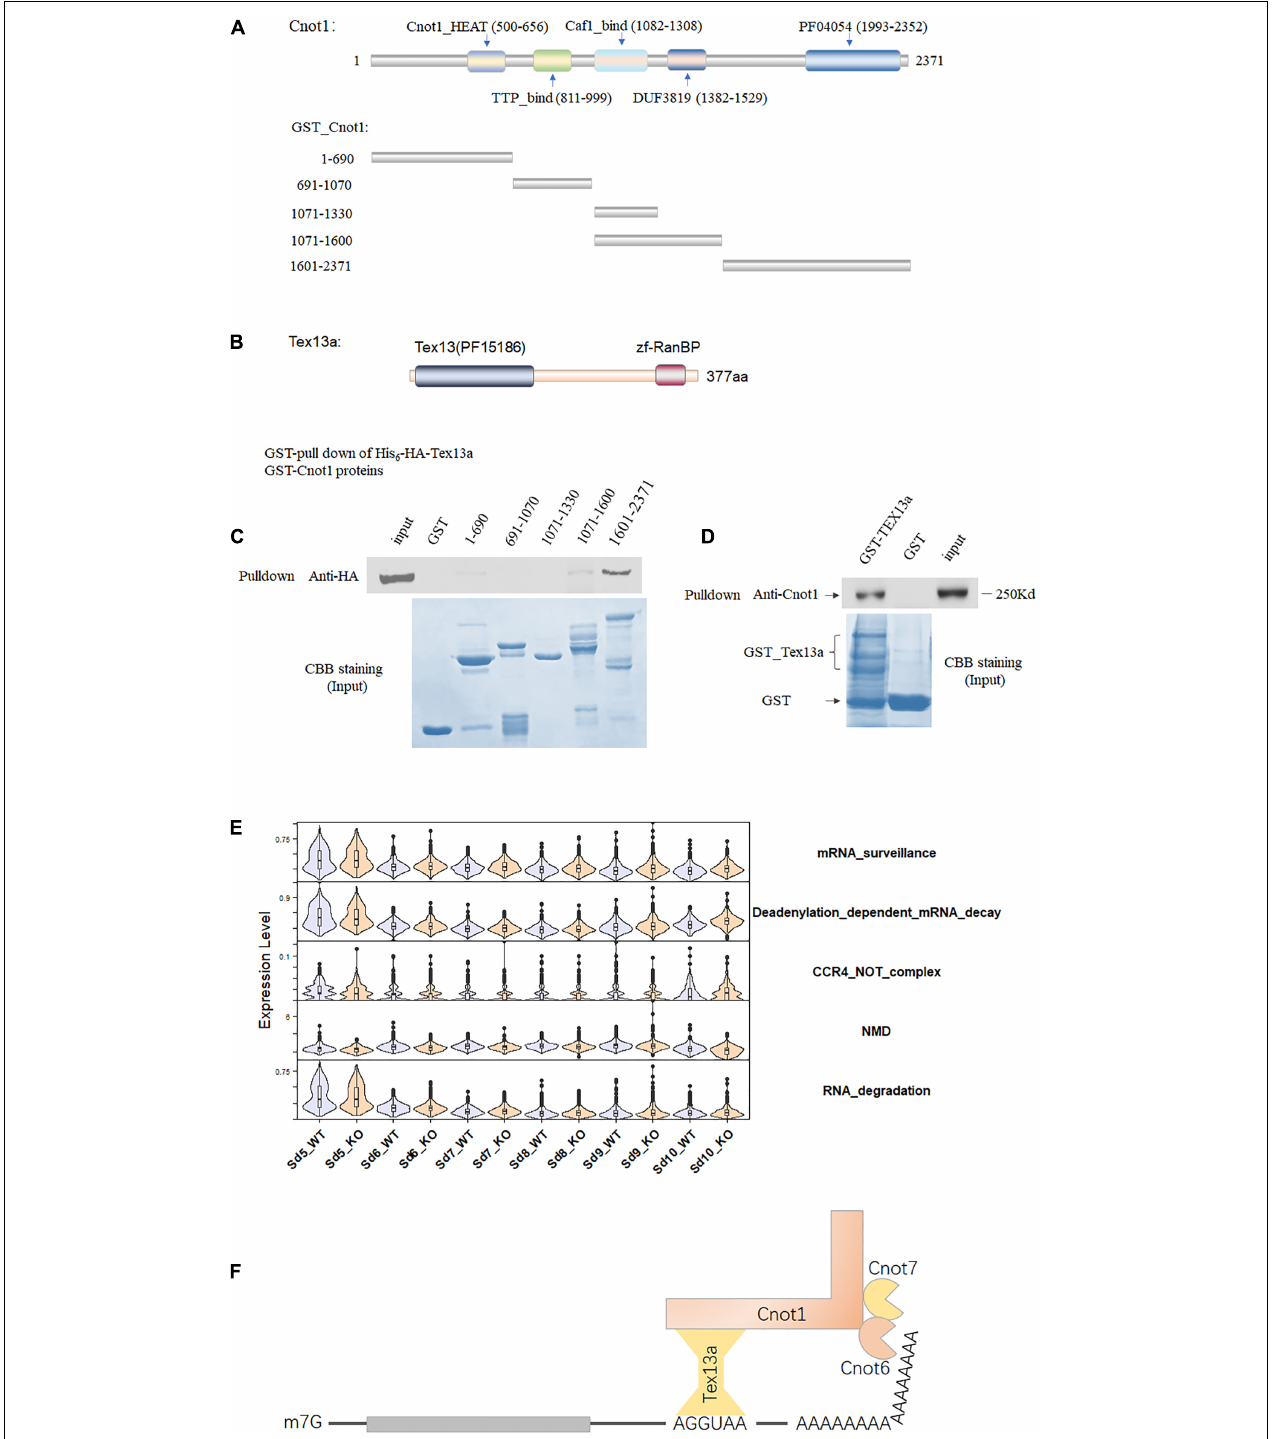
FIGURE 2 | The association of Tex13a with the CCR4–NOT complex. (A) The five domains of Cnot1, the five truncated segments of Cnot1 in fusion with GST in the N-terminus facilitated recombinant protein expression. (B) Diagram showing the domains of Tex13a. (C) GST pull-down analysis of His6-HA-Tex13a with the five recombinant GST-tagged segments of Cnot1 in vitro . Recombinant proteins were stained with Coomassie brilliant blue (CBB) staining. (D) Endogenous Cnot1 of mouse testes was pulled down by recombinant GST_Tex13a. (E) The expression profiles of four RNA metabolism-related pathways from Sd5 to Sd10 in between WT and KO. (F) A proposed interaction model of Tex13a with CCR4–NOT complex.